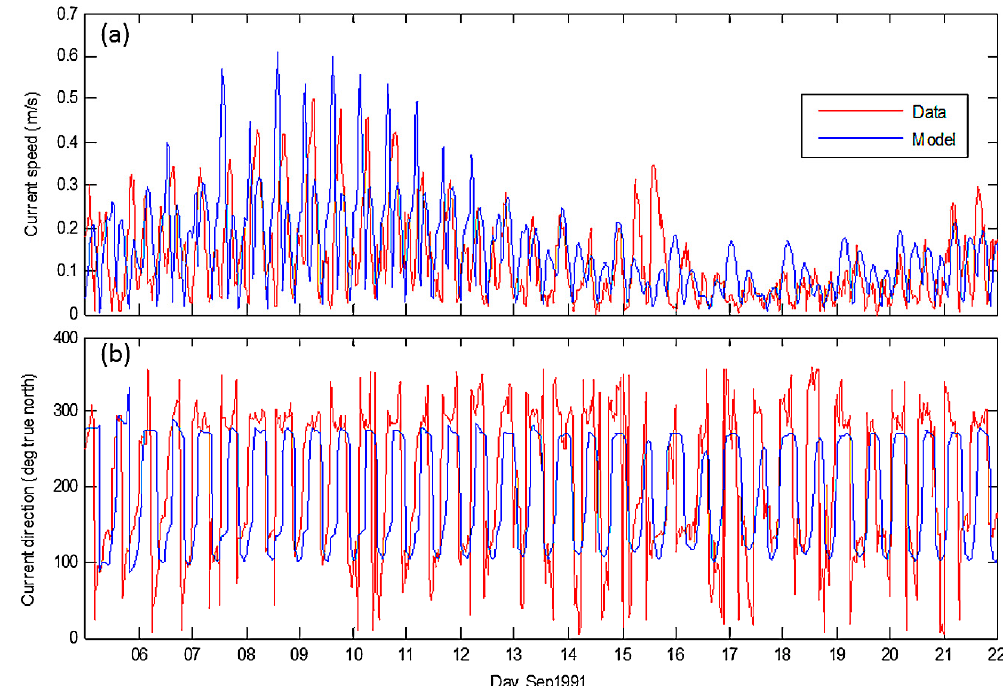
Figure 6. Modeled and measured results of current ( a ) speeds and ( b ) directions located at the historical ocean current mooring site marked in Figure 4 for near-surface ocean currents at 15 m depth. As Figure 4 in [2].